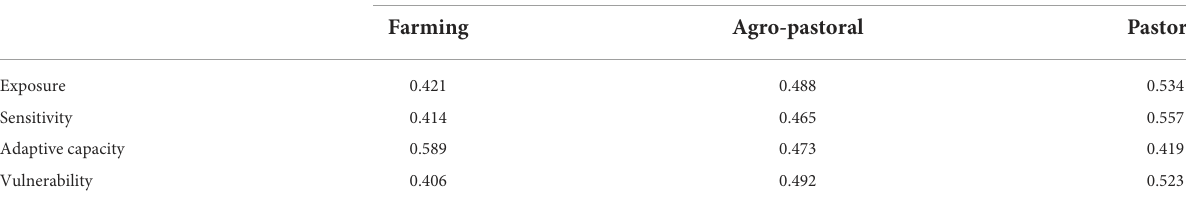
TABLE 5 The index score for vulnerability and its main